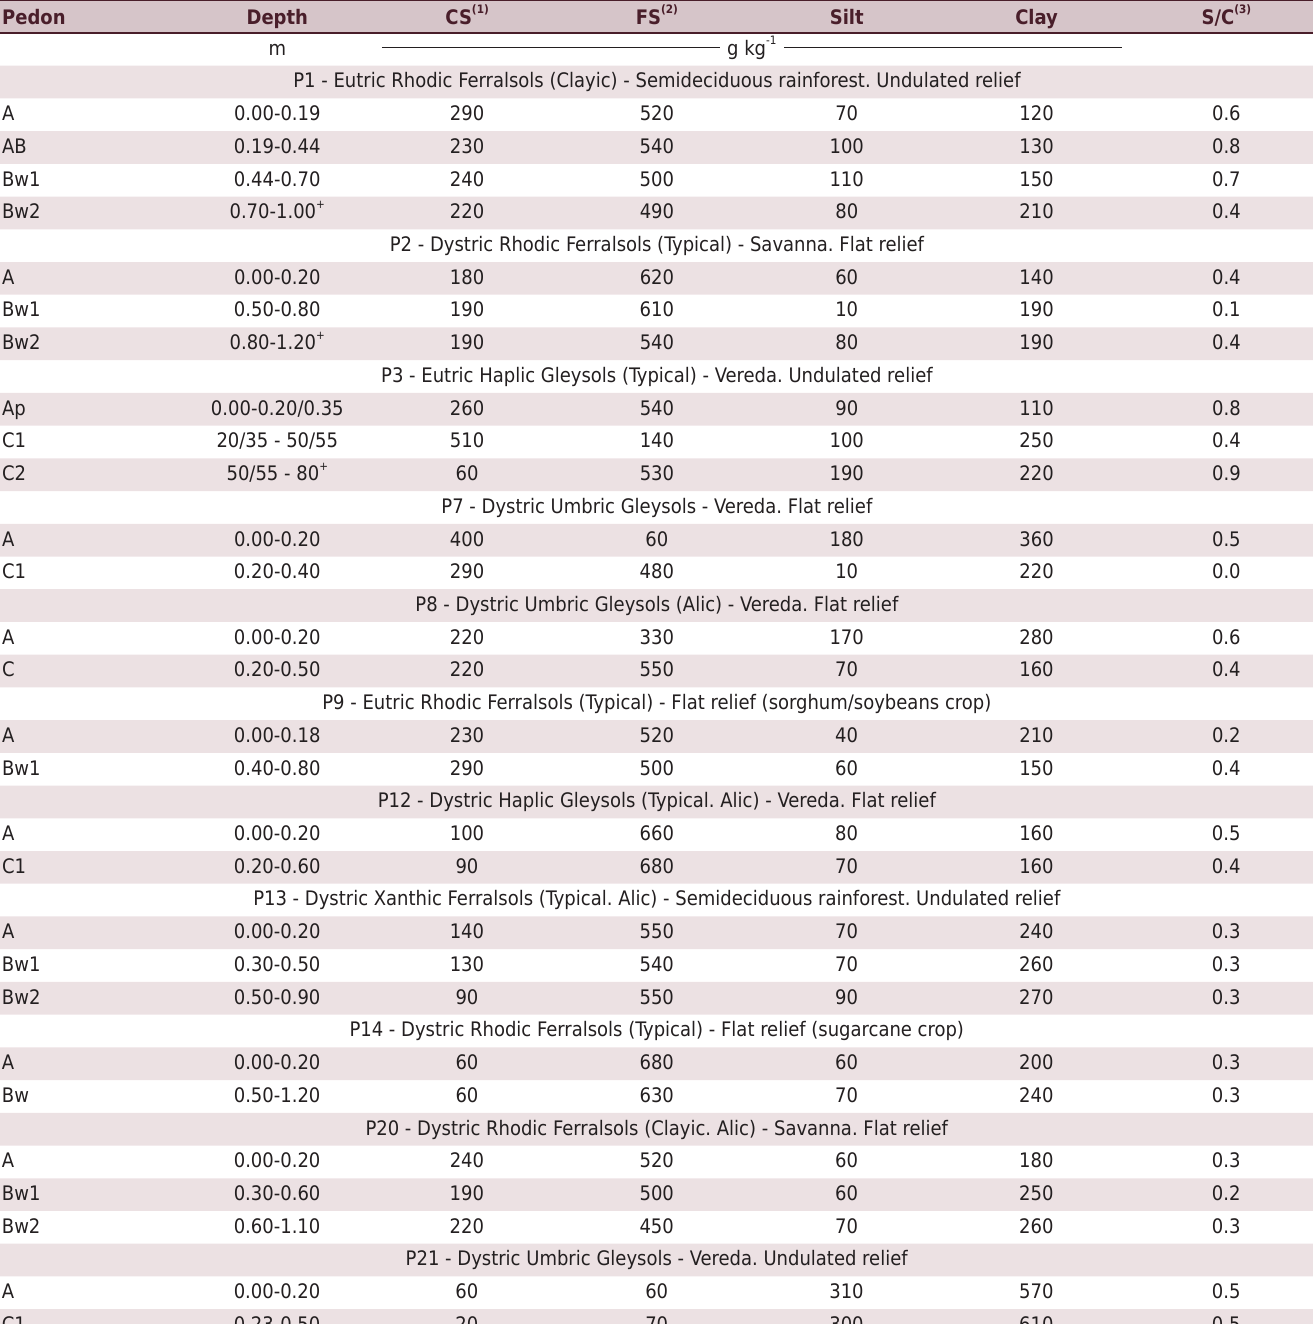
Table 3. Physical properties of some selected studied soils